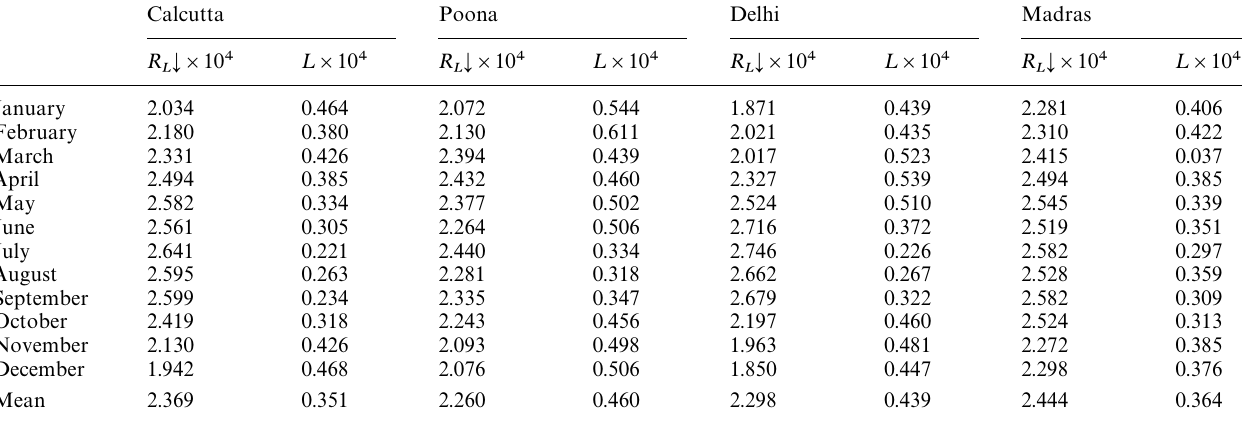
Table 2. Mean monthly values (in J · m (cid:126)(cid:50) · min (cid:126)(cid:49) ) of downward longwave radiation flux ( R (cid:76) (cid:66) ) and net outgoing longwave radiation ( ‚ ) on clear nights Calcutta Poona Delhi